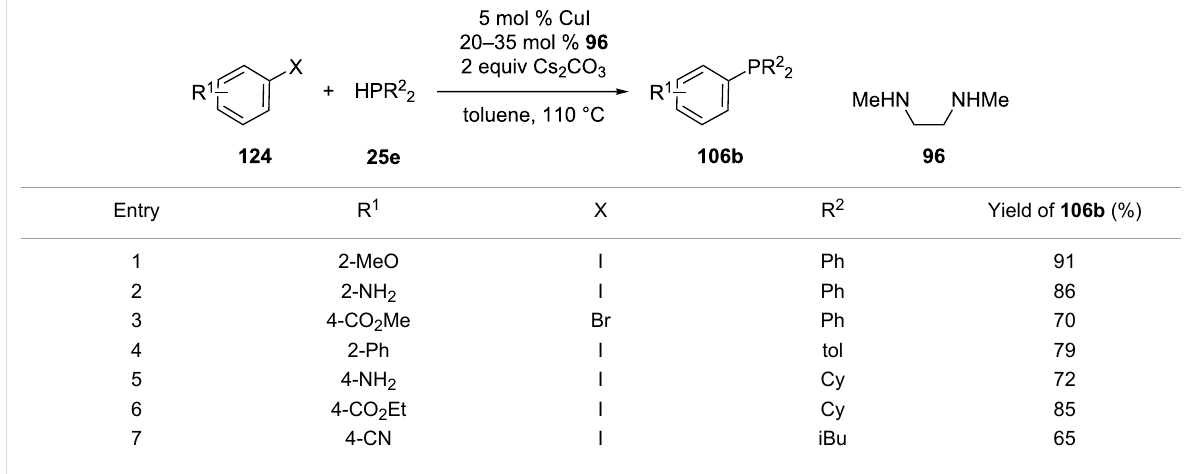
Table 13: Copper-catalyzed synthesis of triarylphosphines 106b .